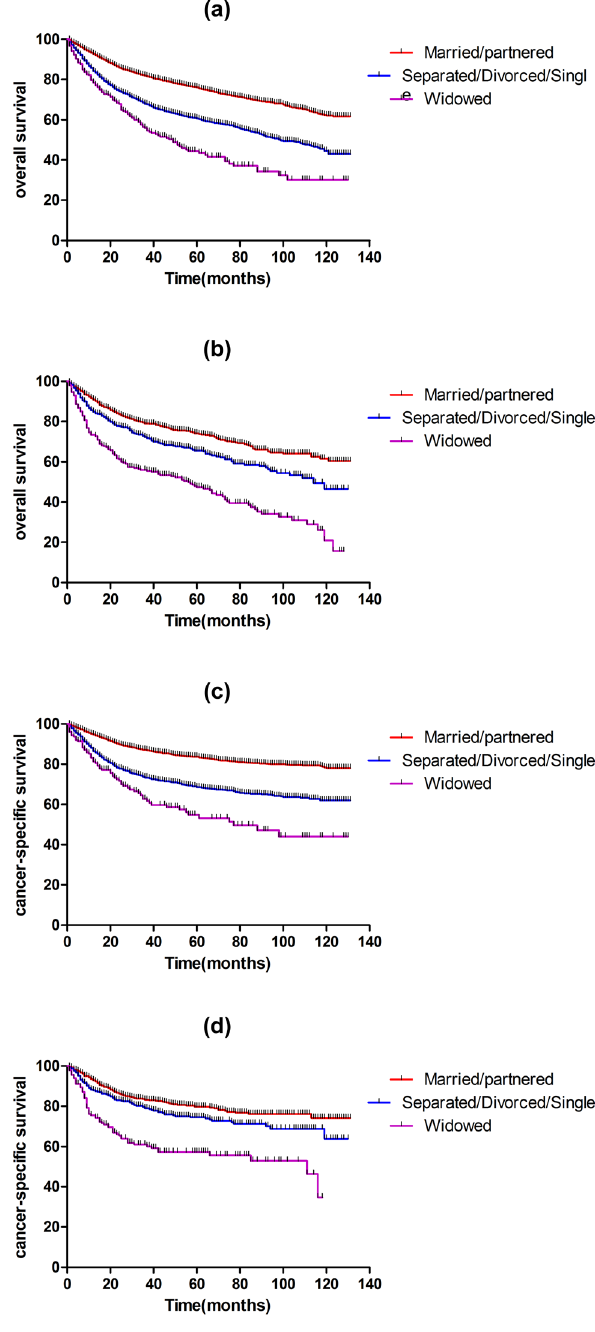
Figure 1: Kaplan – Meier analysis of OS and CSS in male and female TSCC patients: ( a ) OS in male TSCC patients ( log rank p < 0.001 ) , ( b ) OS in female TSCC patients ( log rank p < 0.001 ) , ( c ) CSS in male TSCC patients ( log rank p < 0.001 ) , and ( d ) CSS in female TSCC patients ( log rank p < 0.001 )